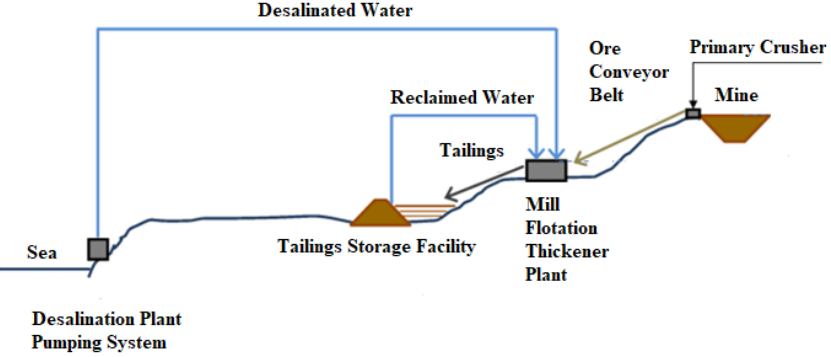
Figure 13. Schematic view of mining project with desalinated water use. Table 4 presents the results of total cost of comparative analysis of alternatives of this study case. Table 4. Comparative Analysis—Tailings Management Methodology Alternatives Cost Estimate.